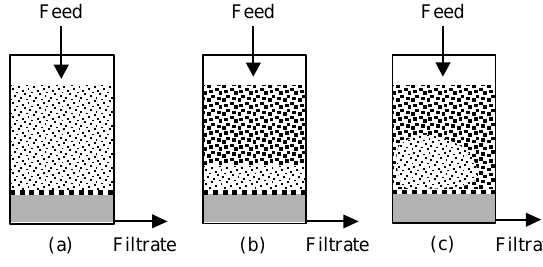
The variation of the medium resistance with vibration fre- quency with clean liquid flowing through the medium (no filtration). The variation of the medium resistance with vibration acceleration with clean liquid flowing through the medium (no